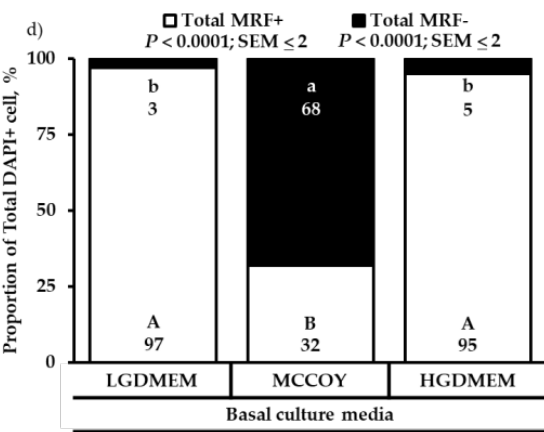
Figure 3. The effect of basal culture media and proliferation sera on total DAPI+ cells ( a ), total MRF+ and total MRF- cells ( b ), proportions of total MRF+ or total MRF- cells to total DAPI+ cells ( c ), and the main effect of basal culture media on total MRF+ or total MRF- cells to total DAPI+ cells at 96 h post-plating ( d ). Cells were cultured in either low glucose Dulbecco’s Modified Eagles medium (LGDMEM), McCoy’s 5A (MCCOY), or high glucose Dulbecco’s Modified Eagles medium (HGDMEM) supplemented with either 5% horse serum + 10% chicken serum (HSCS) or 15% chicken serum (CS). a–d Means with different superscripts describe a difference p < 0.05 and were generated from the pairwise mean comparison analysis. x–z Means with different superscripts describe a tendency 0.10 < p < 0.05 and were generated from the pairwise mean comparison analysis.